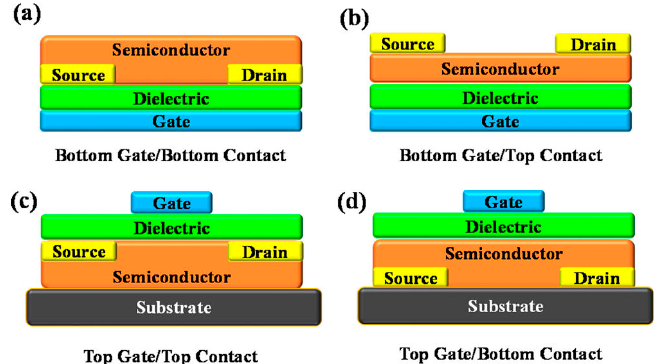
Figure 13. Schematic diagram of four types of TFTs (TFTs: Thin film transistors); ( a ) bottom gate/bottom contact structure; ( b ) bottom gate/top contact structure; ( c ) top gate/top contact structure; ( d ) top gate/bottom contact structure.